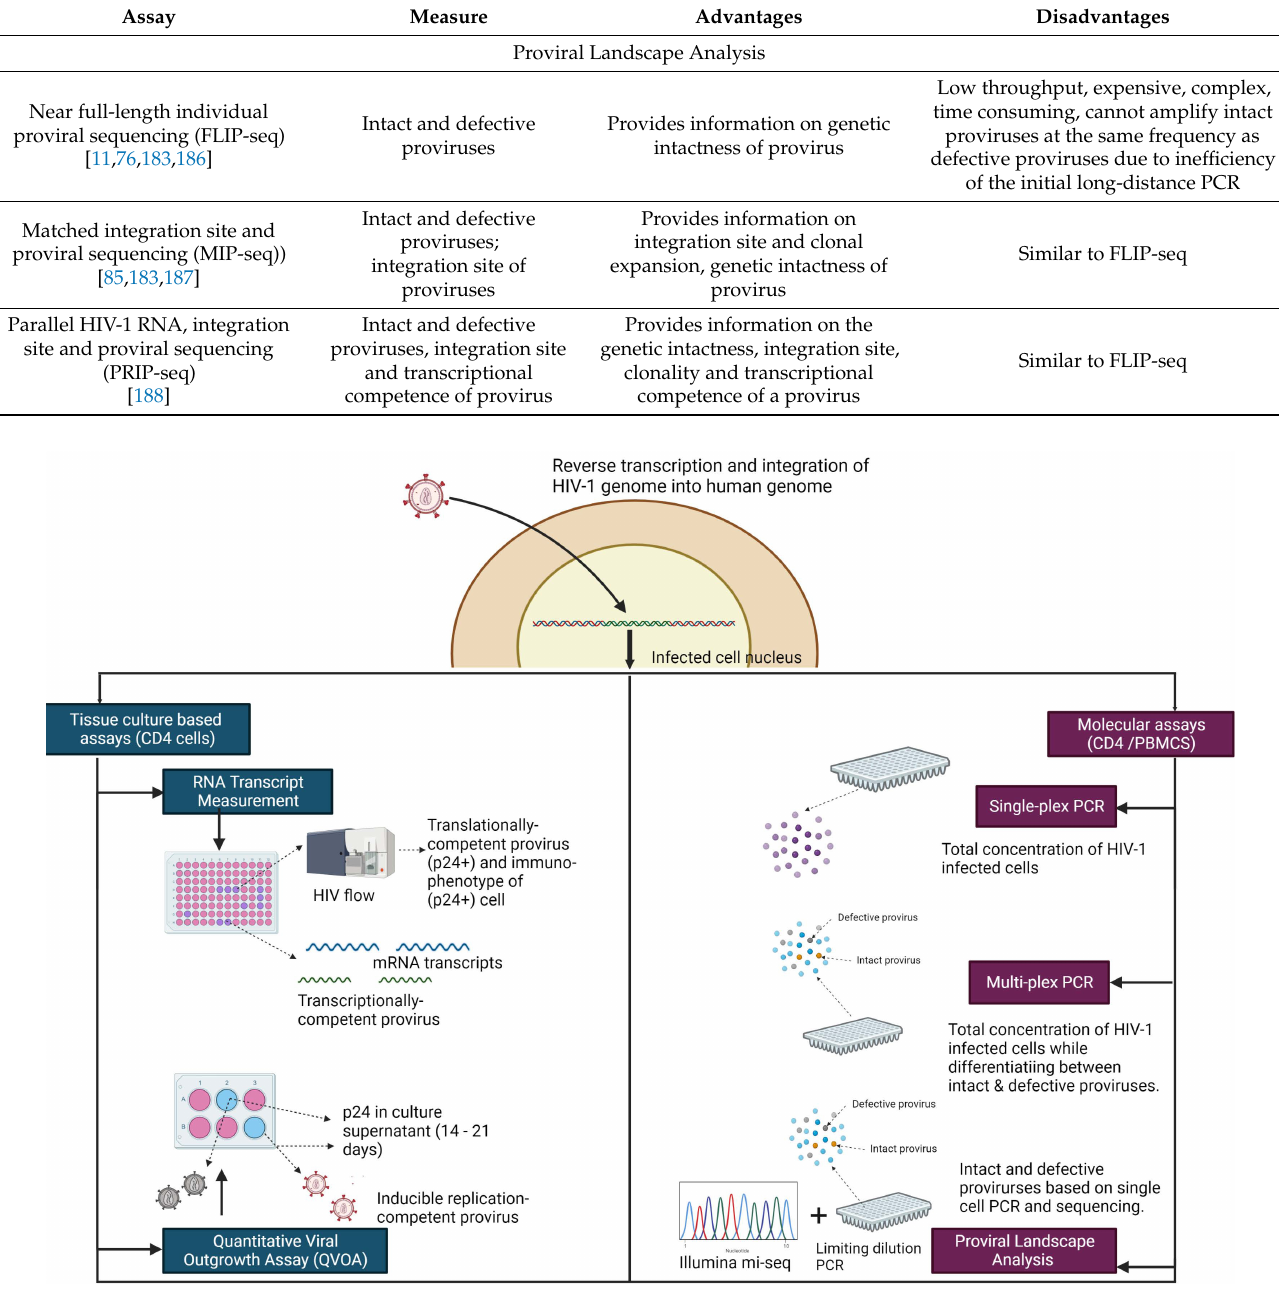
Figure 2. Assays used to measure the HIV-1 reservoir. HIV enters the cell nucleus and forms the proviral reservoir by inserting the cDNA of its genome into the host genome. The proviral reservoir is complex and made of several different species which can be measured using different assays that fall under two categories: Tissue culture-based assays and Molecular assays. Tissue culture-based assays (on the left) can measure the transcriptional competence of the provirus (TILDA) or the replication competence and infectivity of the provirus (QVOA). Molecular assays (on the right) can provide the total concentration of infected cells (single-plex ddPCR) or differentiate between intact and defective proviruses (multi-plex ddPCR). Molecular assays can also be used to study the dynamics of the proviral landscape using near full-length PCR and next generation sequencing technology. All of these assays provide key information about the reservoir dynamics and can be useful in developing and measuring the efficacy of cure interventions. (Figure created with